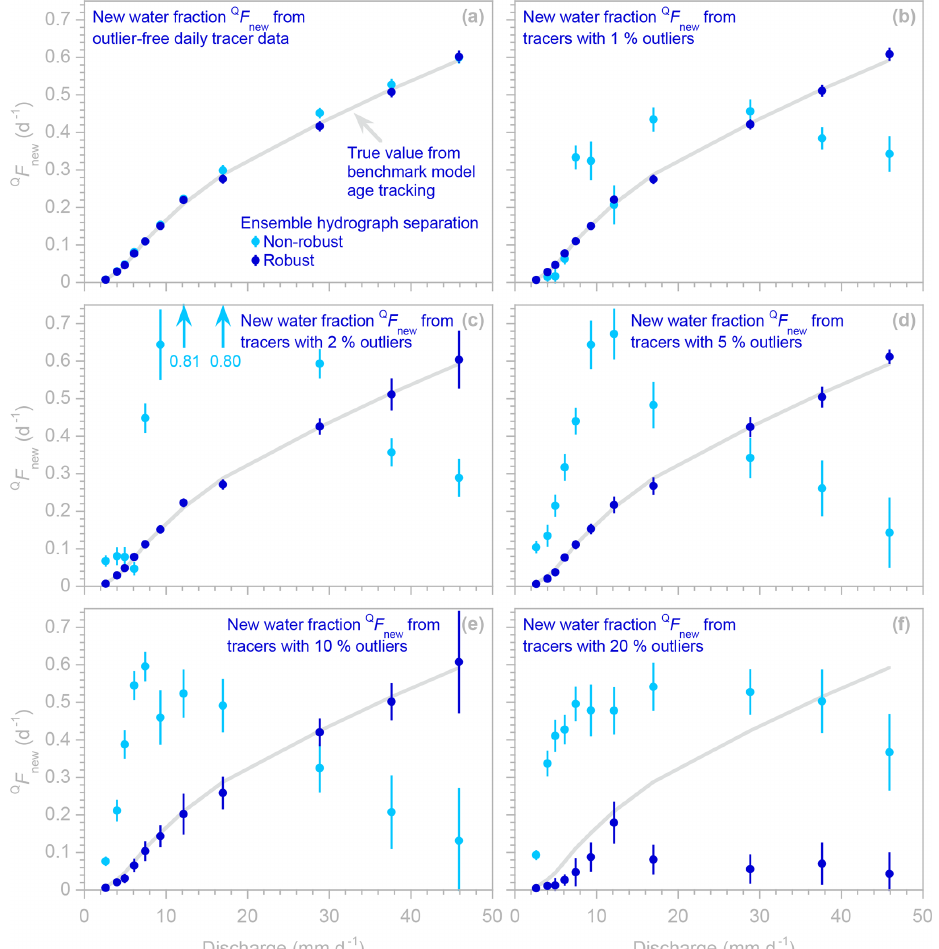
Figure 3. Profiles illustrating how new water fractions of discharge change with discharge regime, estimated using robust and non-robust methods (dark and light blue symbols, respectively; error bars indicate 1 standard error) applied to synthetic benchmark tracer data without different percentages of outliers. In profiles generated from outlier-free data (a) , many light blue symbols are invisible because they are directly overprinted by dark blue symbols. The light gray line indicates the true new water fraction, as calculated from water age tracking in the benchmark model. The non-robust estimates (light blue symbols) closely follow the true values (gray line) if the tracer time series are outlier-free (a) but deviate markedly if they are corrupted by outliers (b–f) , even if those outliers comprise only a few percent of the data (b–d) . The robust estimates (dark blue symbols) closely follow the true values (gray line), until the outliers become so frequent that the robust estimation algorithm is no longer effective against them (f)